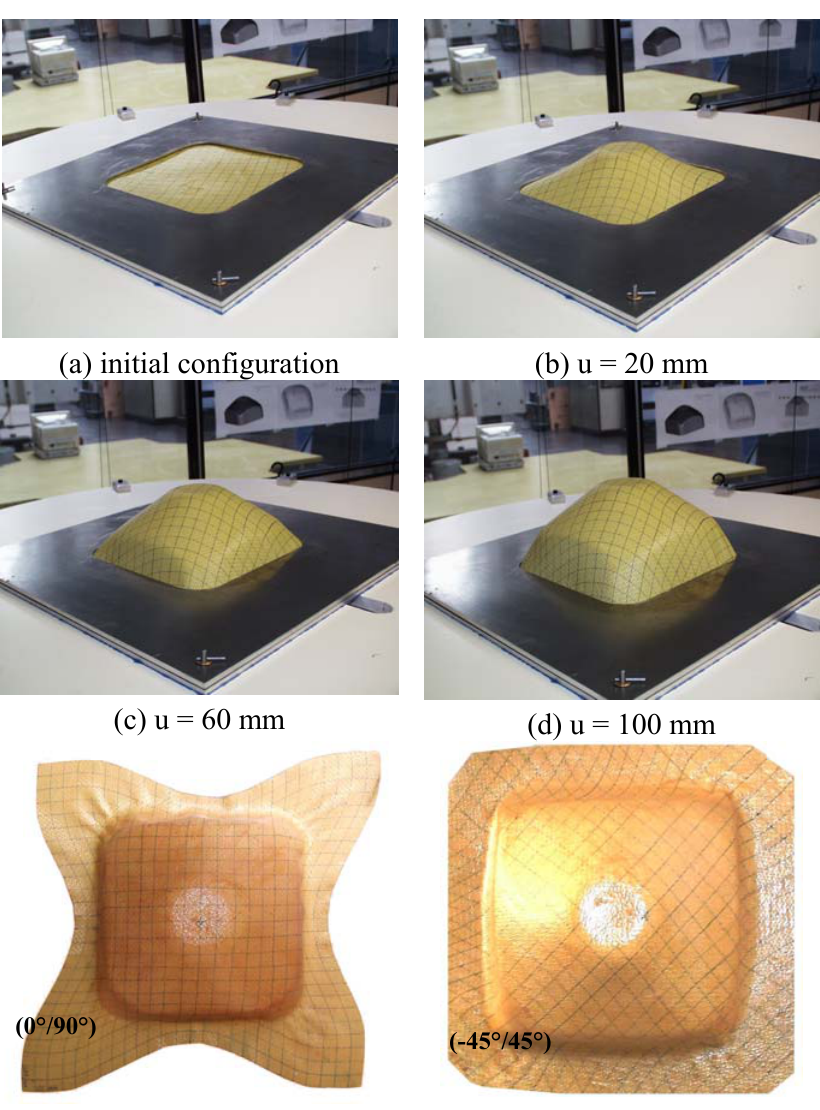
Figure 13. Experimental results (a) (0°/90°) and (b)